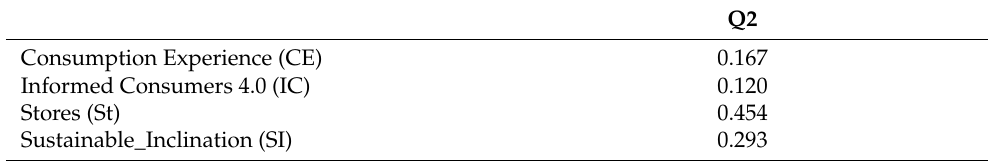
Table 9. Construct cross-validated